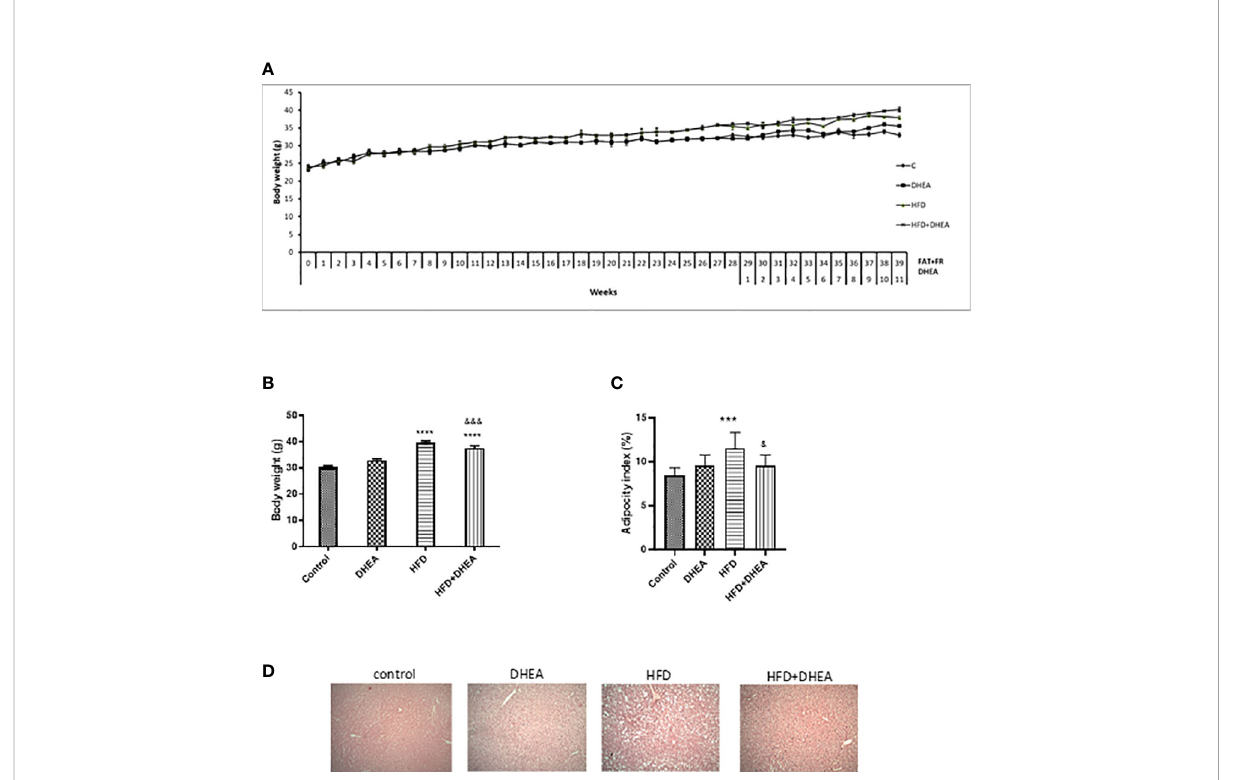
FIGURE 1 DHEA supplementation effects on body weight, adipocyte tissue, and steatosis induced by HFD. Mice were fed with chow or HFD for 40 weeks and supplemented with or without DHEA (0.05% w/w) starting at week 28. Weekly body weight (A) , fi nal body weight (B) , and white adiposity index (C) . H&E stained livers showing levels of steatosis between groups (100× magni fi cation) (D) . Data are means ± SEM (n = 9 per group). ***P < 0.001 ****P < 0.0001 versus C; &P < 0.05, &&&P < 0.001 versus HFD according to one-way ANOVA analysis with multiple comparisons.